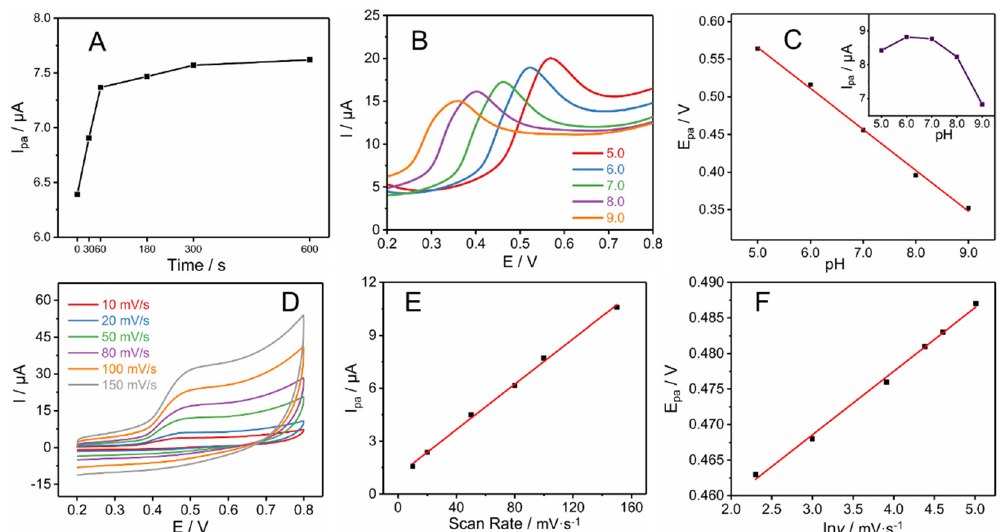
Figure 5. ( A ) Effect of adsorption time; ( B ) differential pulse voltammograms at different pH values; ( C ) point line graph of oxidation peak current (I pa ) vary with pH and the variation of peak potential (E pa ) with pH. ( D ) Cyclic voltammograms of ZnO/BC sensor at different scan rates, ( E ) variation of I pa with the scan rate ( v ), ( F ) variation of E pa with the natural logarithm of scan rate (ln v ).